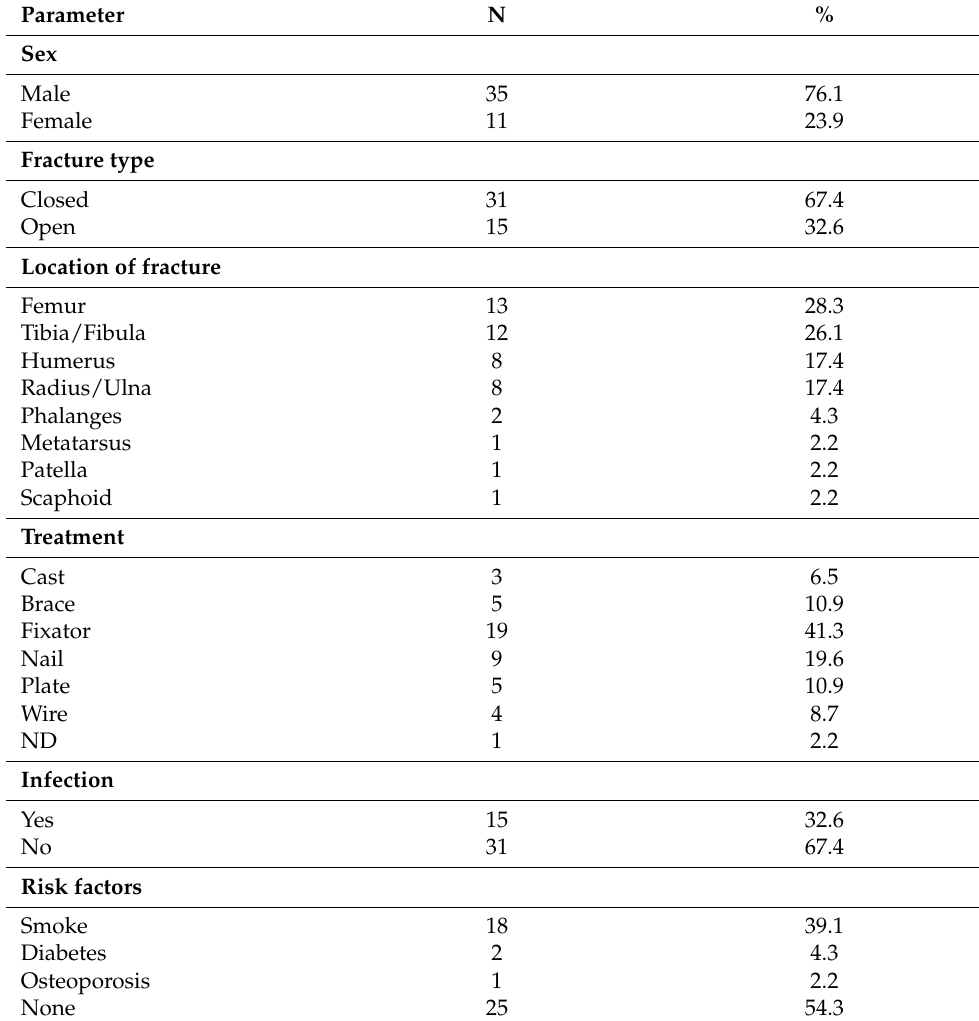
Table 1. Nonunions: demographics and clinical characteristics at